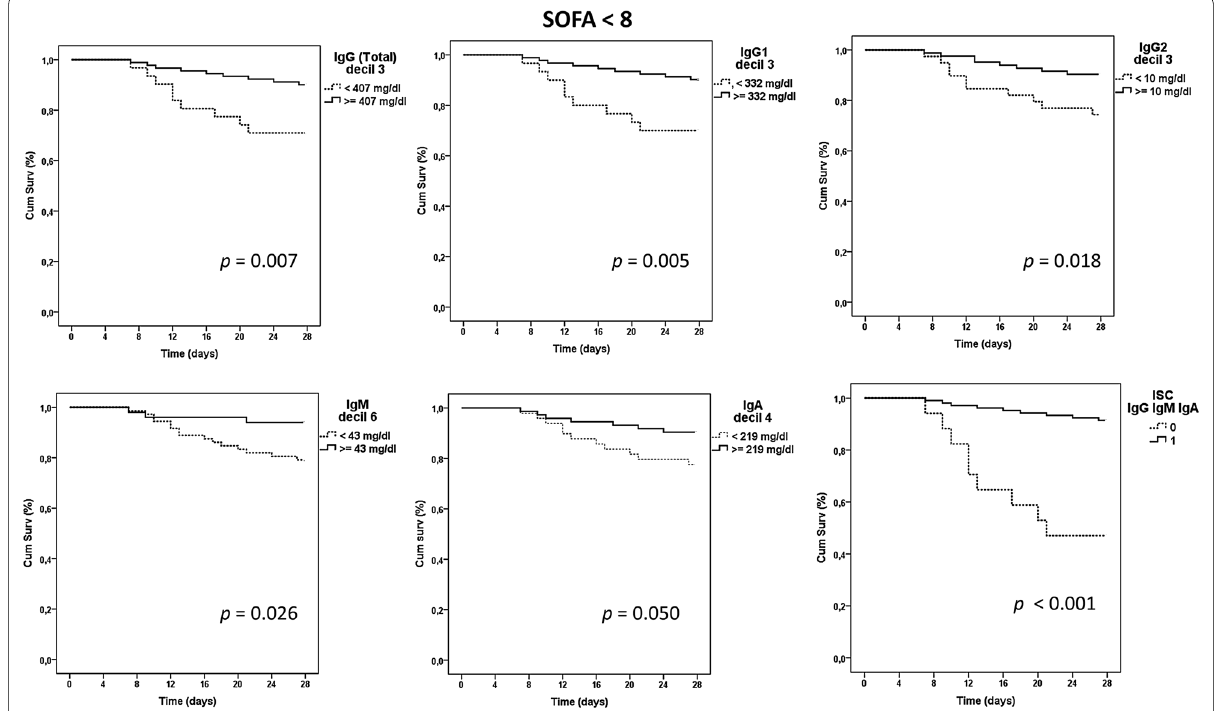
Fig. 1 Kaplan–Meier analysis for survival depending on immunoglobulin levels in the group with SOFA <